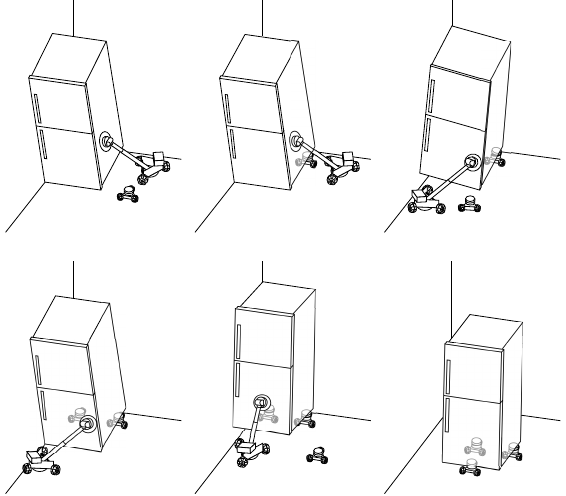
Figure 1. Example of non-prehensile transportation adopting multiple mobile robot: Two types of mobile robots move the refrigerator placed at the corner of a